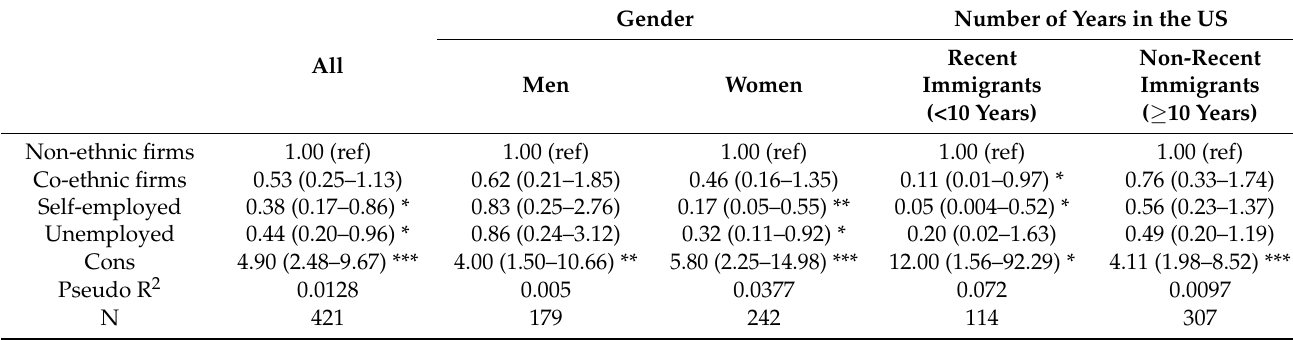
Table 2. Relationship Between Self-Rated Health and Employment Type by Gender and Number of Years in the US (OR, 95%